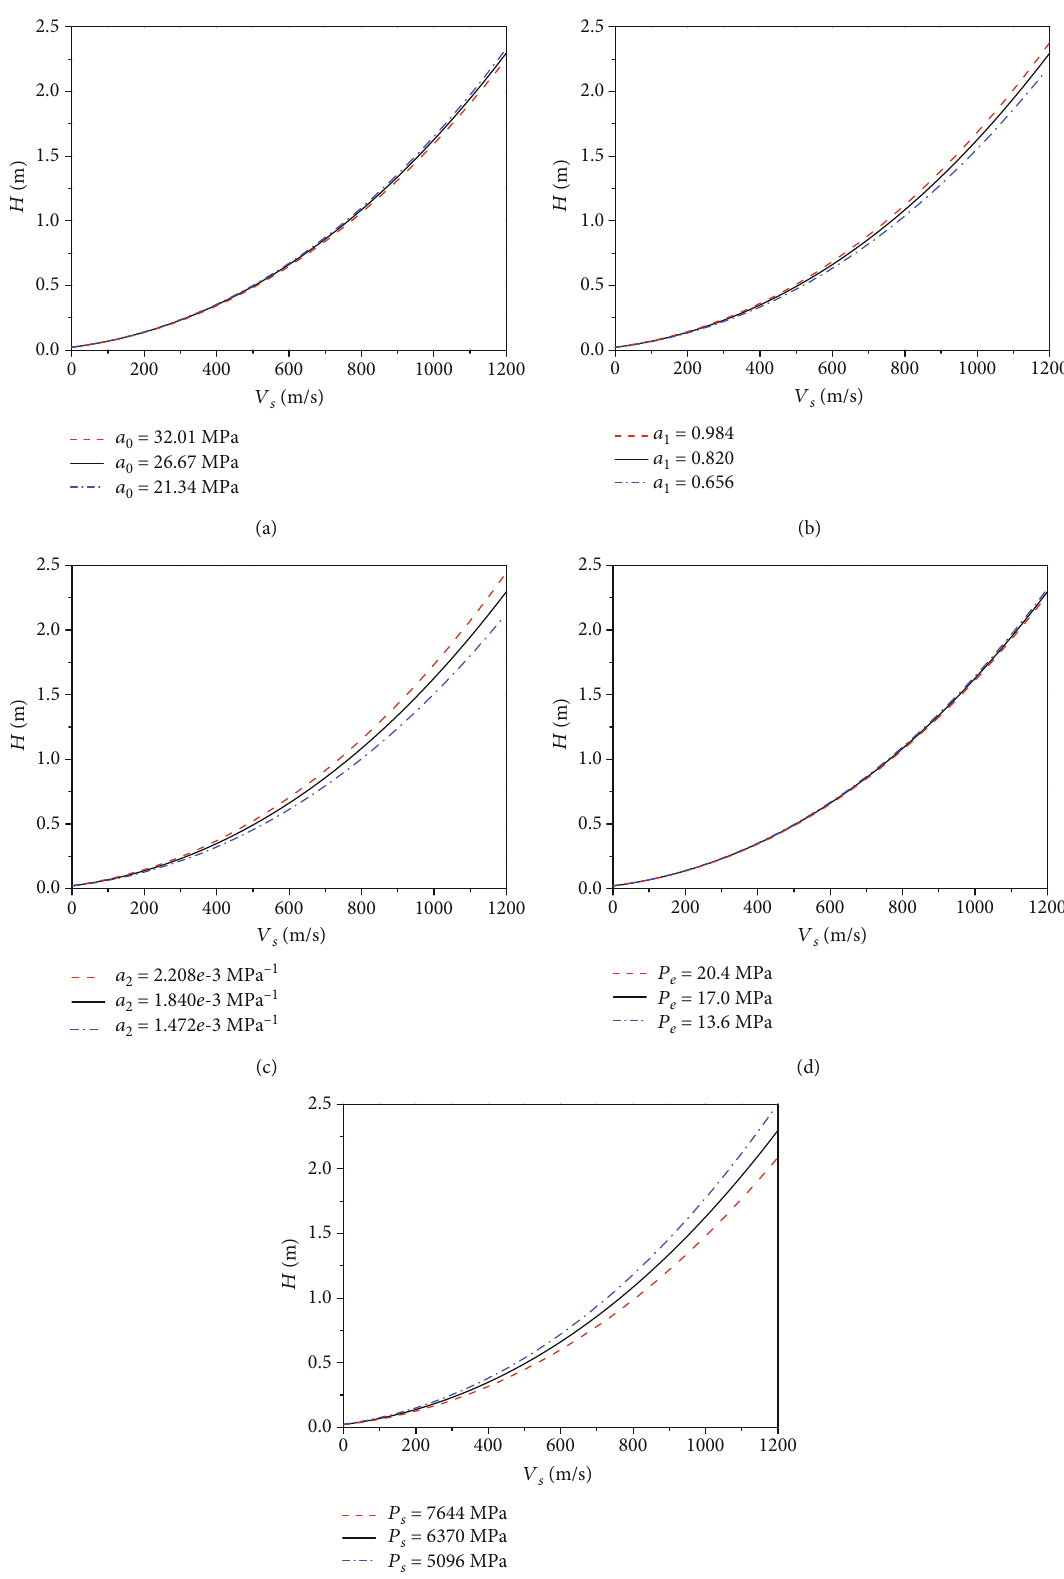
Figure 8: In fl uence of the target material parameters on the DOP (a) a